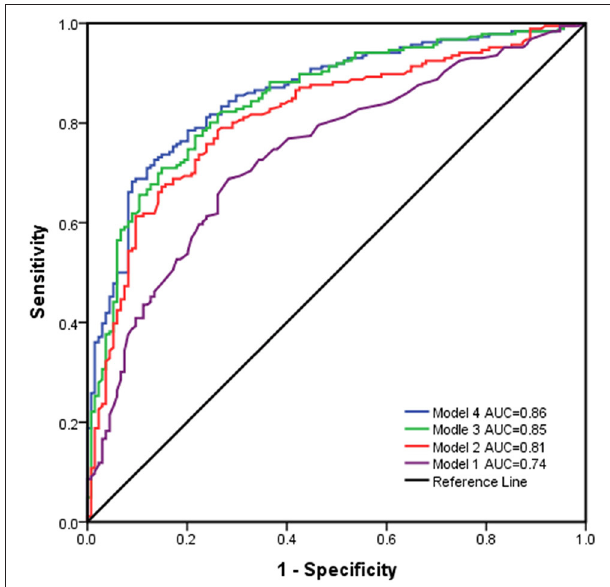
FIGURE 2 | Receiver operating characteristic curves for the different prognostic